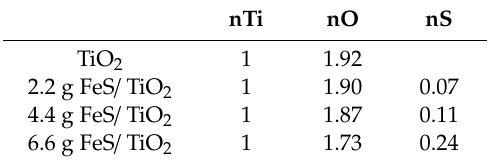
Table 2. The atomic ratio of each element is obtained by